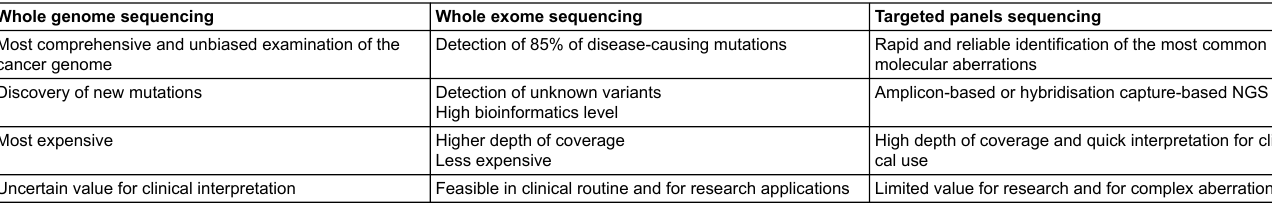
Table 1: Characteristics of DNA sequencing strategies. Whole genome